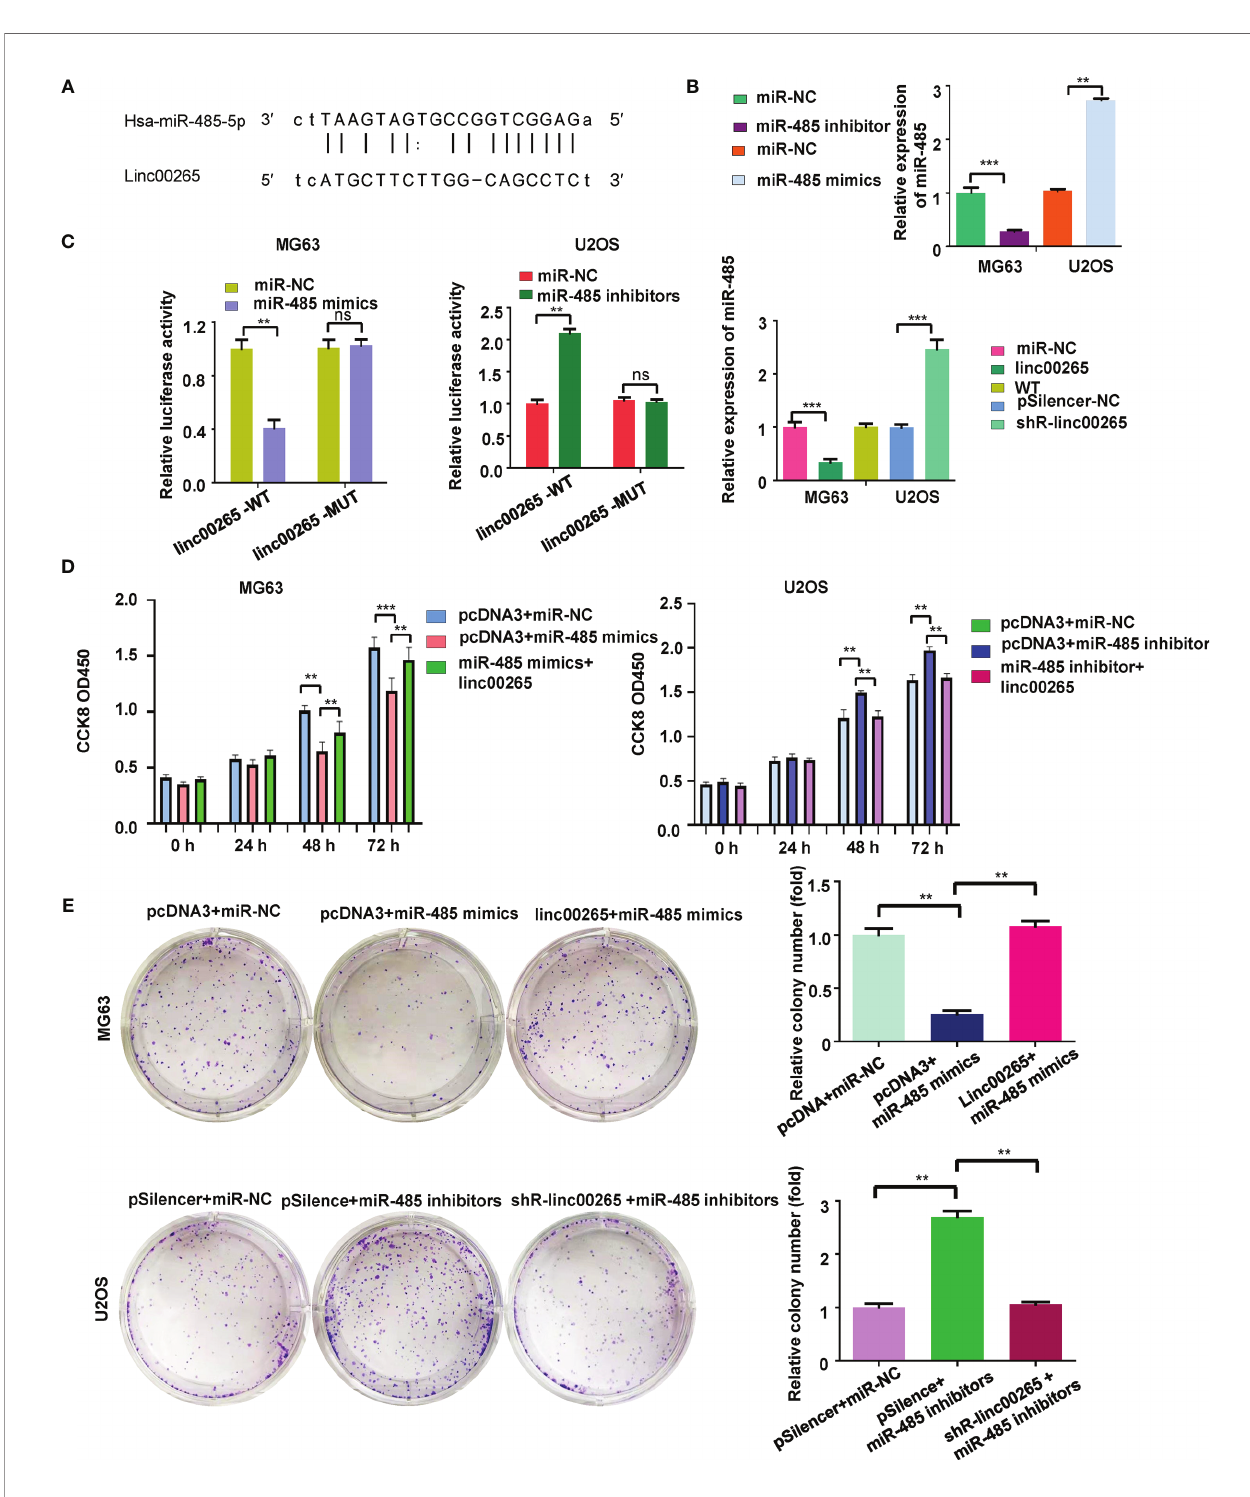
FIGURE 4 | Linc00265 sponges miR-485-5p in osteosarcoma cells. (A) The target gene of linc00265 was predicted by starbase database. (B) The ef fi cacy of transfection was con fi rmed by qRT-PCR in MG63 and U2OS osteosarcoma cells. (C) Luciferase reporter assay was used to con fi rm miR-485-5p as a target of linc00265 (Left and middle panels). The expression of miR-485 was detected by qRT-PCR in MG63 and U2OS osteosarcoma cells after linc00265 changes (Right panel). (D) Cell viability was examined by CCK-8 assay in MG63 and U2OS osteosarcoma cells after linc00265 modi fi cation and miR-485-5p changes. (E) The colony formation ability was measured in MG63 and U2OS osteosarcoma cells after linc00265 modi fi cation and miR-485-5p changes (Left panel). The quantitative data of colony formation ability were demonstrated for colony formation (Right panel). ** P < 0.01, *** P < 0.001 vs. control. ns, no statistic